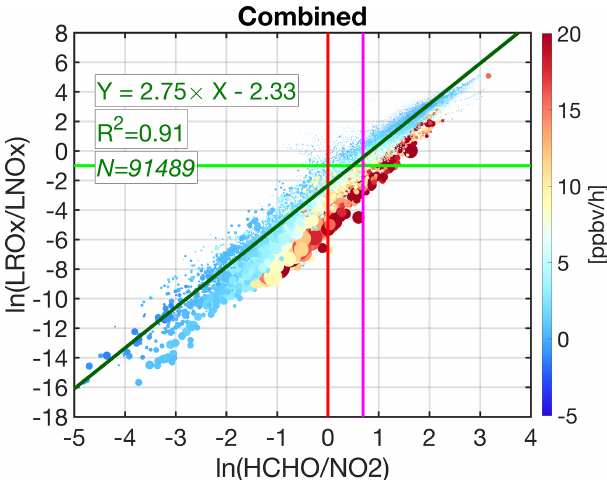
Figure 3. The scatterplot of natural logarithm-transformed HCHO / NO 2 versus LRO x / LNO x based on the simulated values performed by the F0AM box model. The heat color indicates the calculated ozone production rates (PO 3 ). The size of each data point is proportional to HCHO × NO 2 . The black line is the baseline sep- arator of NO x -sensitive (above the line) and VOC-sensitive (below the line) regimes. We overlay HCHO / NO 2 = 1 and HCHO / NO 2 = 2 as red and purple lines, respectively. The dashed dark green line indicates the least-squares fit to the paired data. The HCHO / NO 2 = 1.8 with a 20% error is the optimal transitioning point based on this